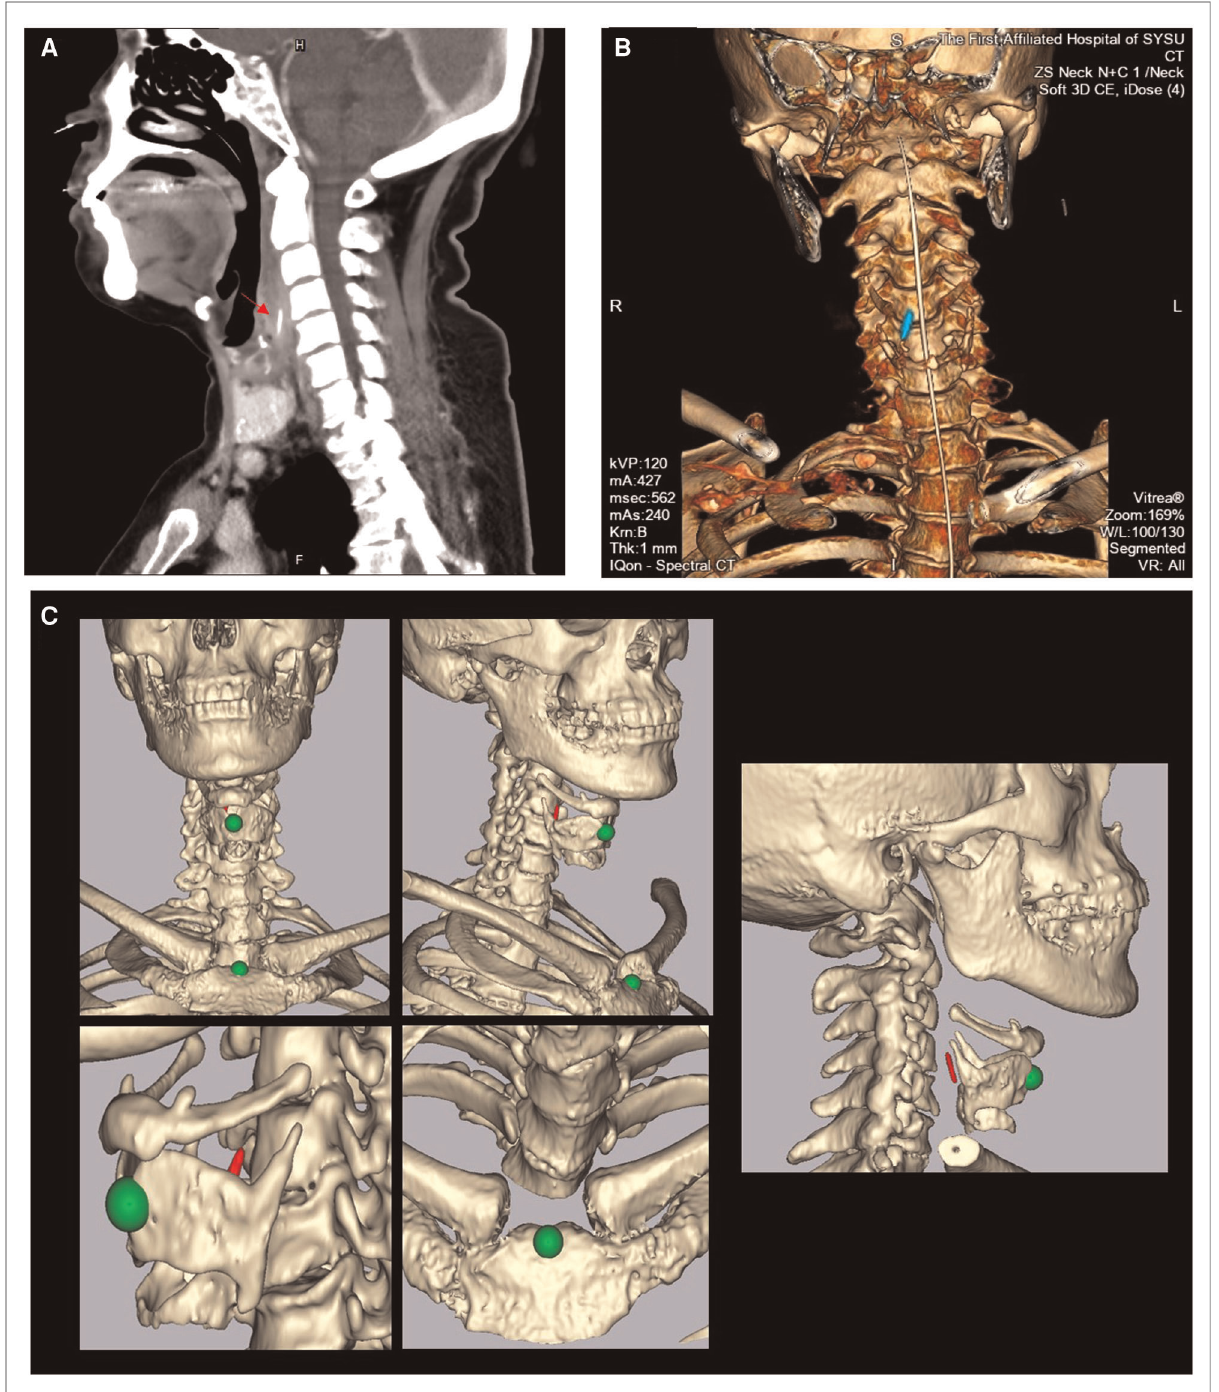
FIGURE 2 ( A , B ) Sagittal CT image and three-dimensional construction image of the patient after direct laryngoscopy (( A ): the red arrow points to the foreign body); ( C ) representative images of intraoperative navigation registration: head and face contour scanning, combined with a facial marker, was used for registration, with an average registration accuracy not greater than 1.0 mm. After the model registration is completed, the patient ’ s body position is further adjusted according to the positioning of the superior thyroid notch and the manubrium sterni (green) in the navigation model, so that the neck position from the navigation model matches the actual position of the patient ’ s